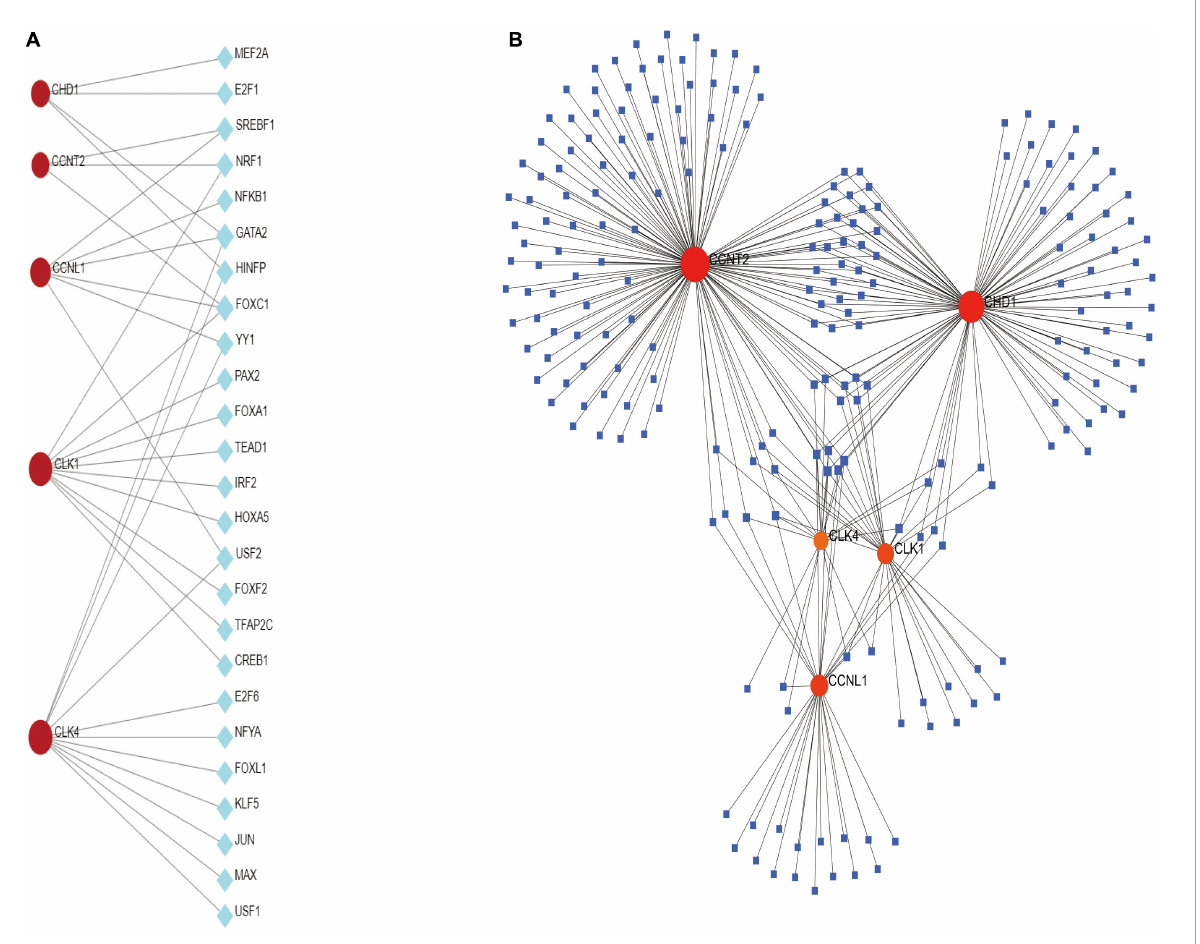
FIGURE5 (A) The cohesive regulatory interaction network of DEG–TFs obtained from the Network Analyst. (B) The interconnected regulatory interaction network of